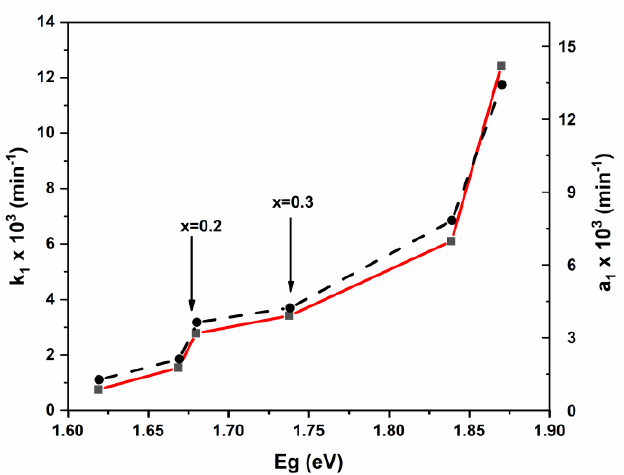
Figure 13. Variation of pseudo rate constant (k1) and modified pseudo-rate constant (a1) vs. bandgap energy.